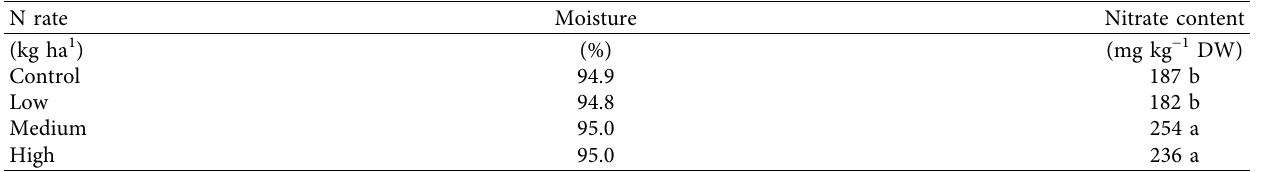
Table 7: Main effect of nitrogen (N) rate on plant moisture content and nitrate